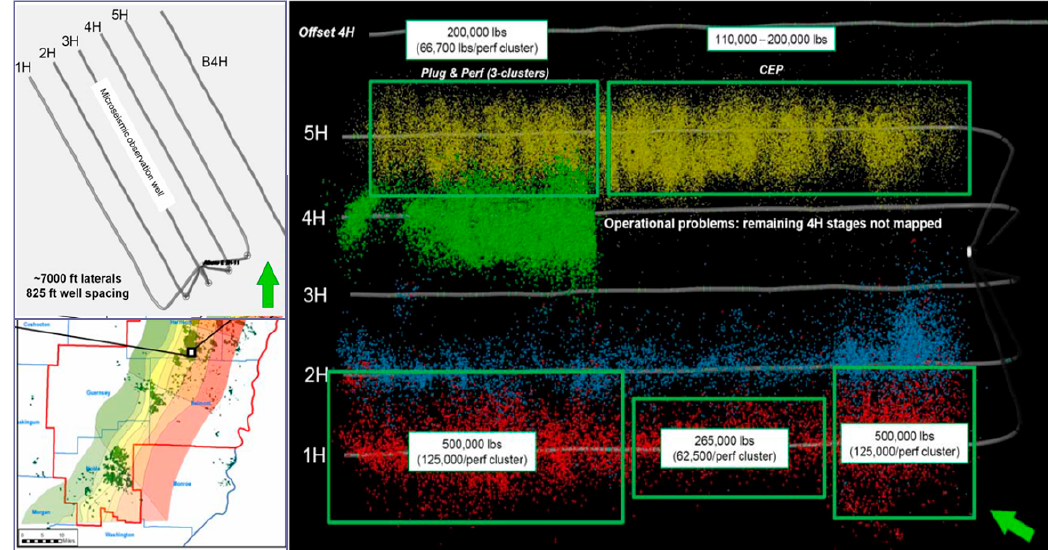
Figure 2. Map view of well layout (upper left) and location in the wet gas window of the Utica Shale Formation, Ohio (lower left). The right image shows map views of the collocated micro-seismic response clouds for the four outer wells in the Utica field test site (adapted from Reference [7]).